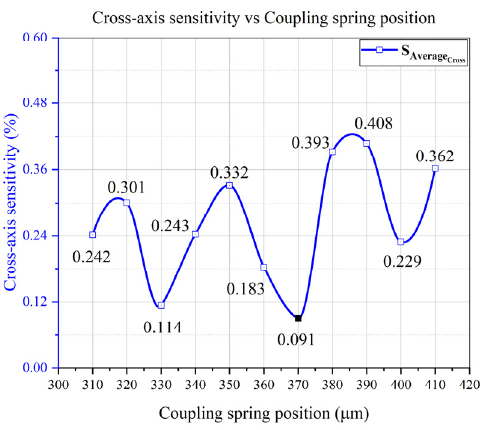
Figure 8. Coupling Spring Position of the Designed MEMS Gyroscope. ( a ) Out Position; ( b ) Center Position; ( c ) Inner Po- sition.